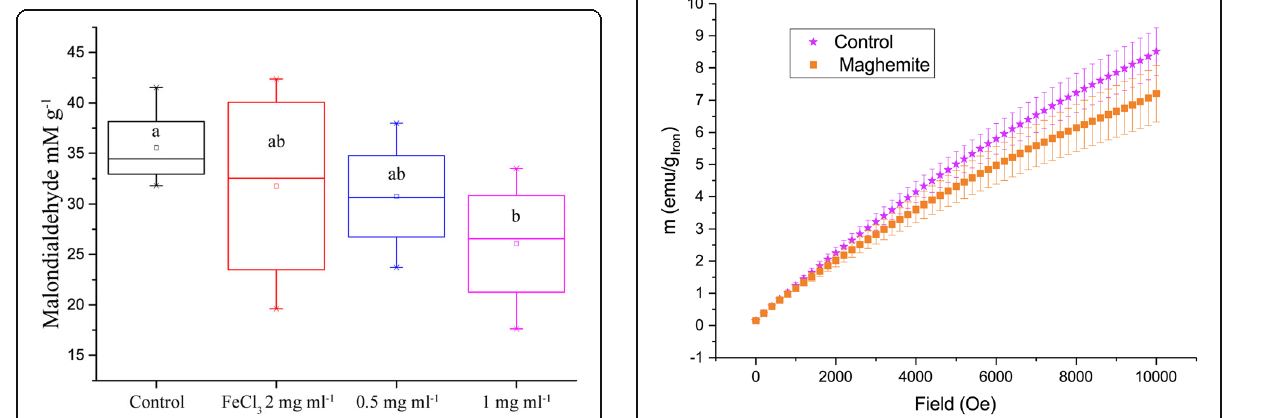
Fig. 6 Concentration of the lipid peroxidation product MDA in the leaves of oilseed rape treated with nutrient solution containing IONs and drought for 5 days ( n = 8, p value =